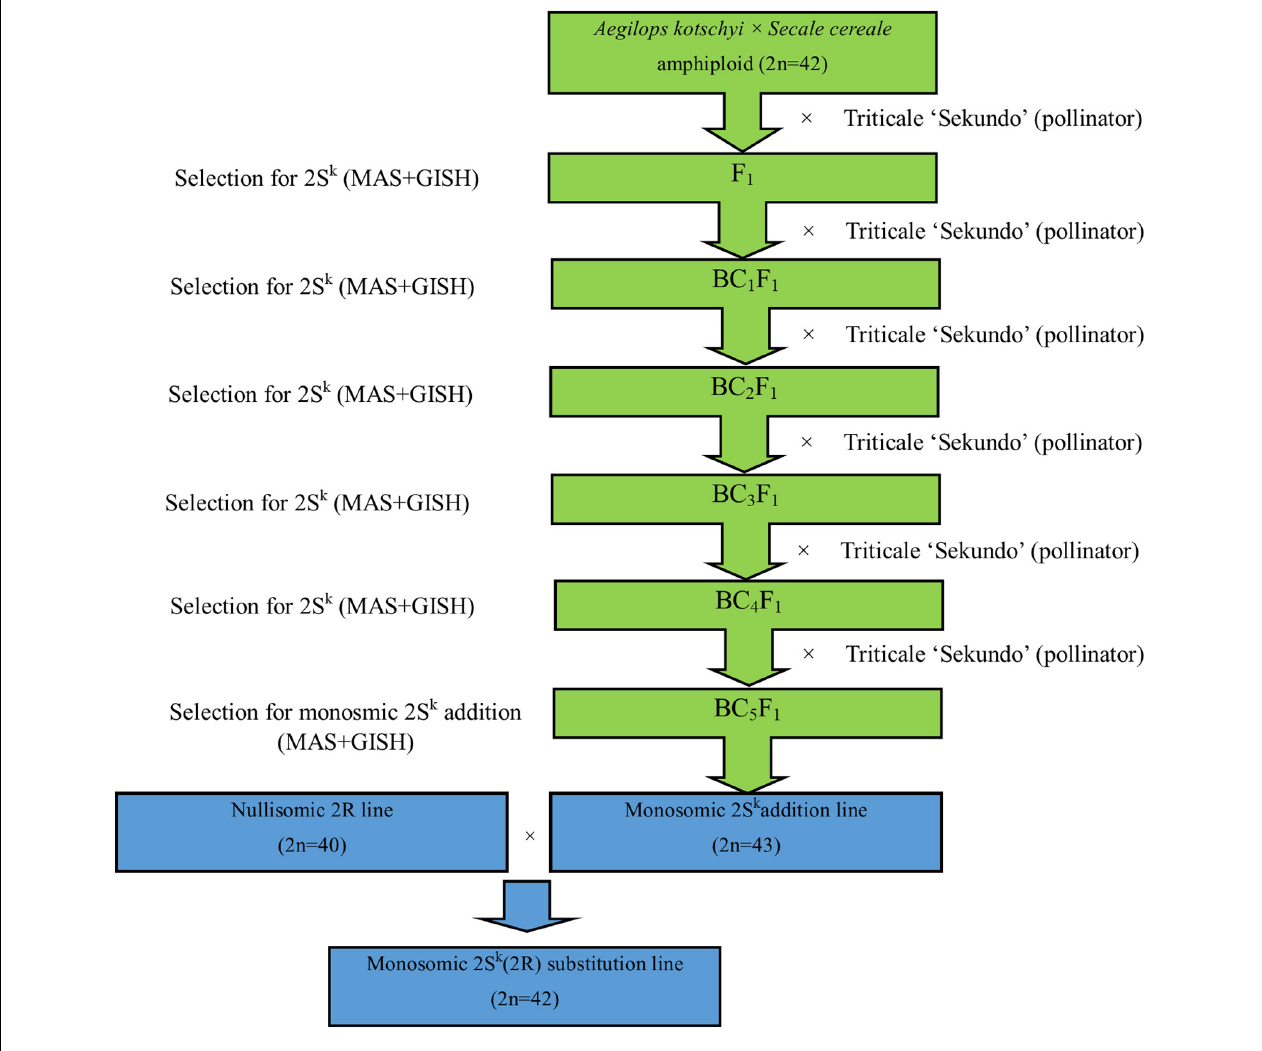
FIGURE 3 | Pedigree of monosomic 2S k (2R) substitution plants of triticale “Sekundo.”